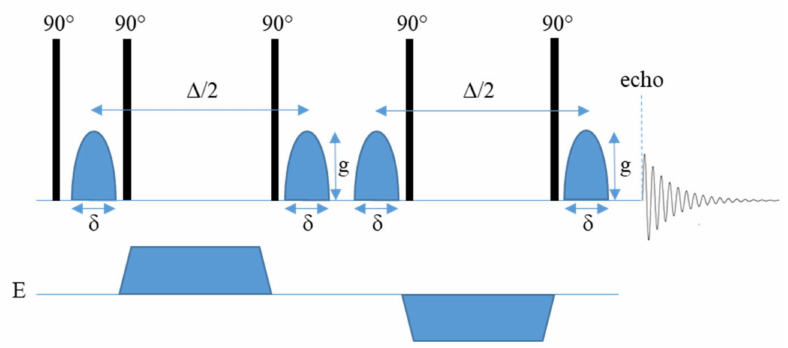
Figure 5. Electrophoretic NMR pulse sequence.